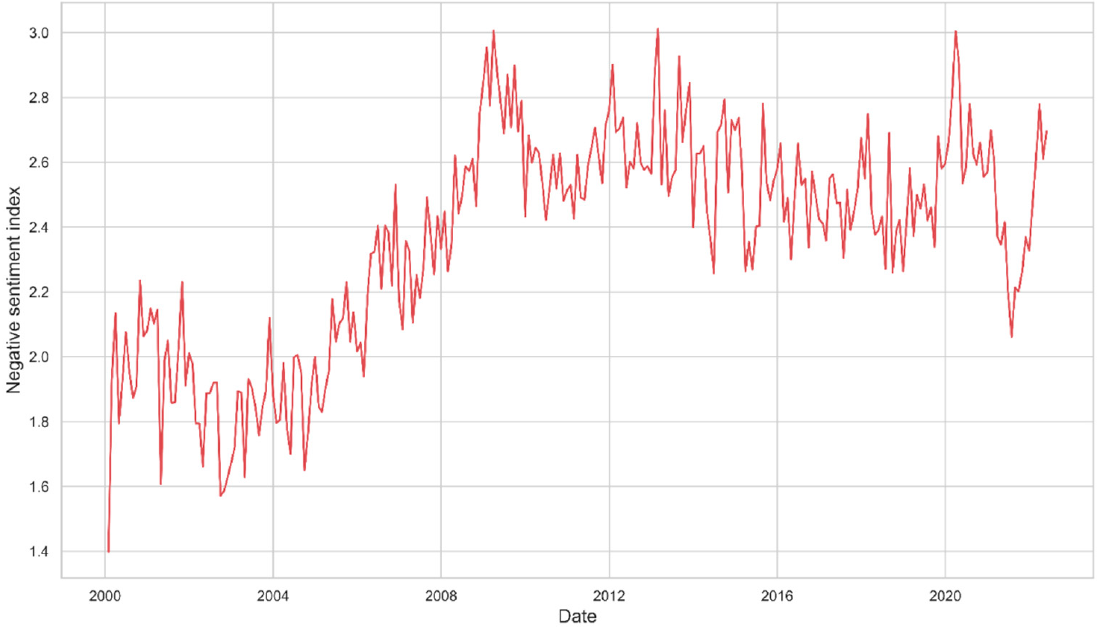
Figure 6. Graphical representation of negative sentiment analysis for the business news category using only news article titles.